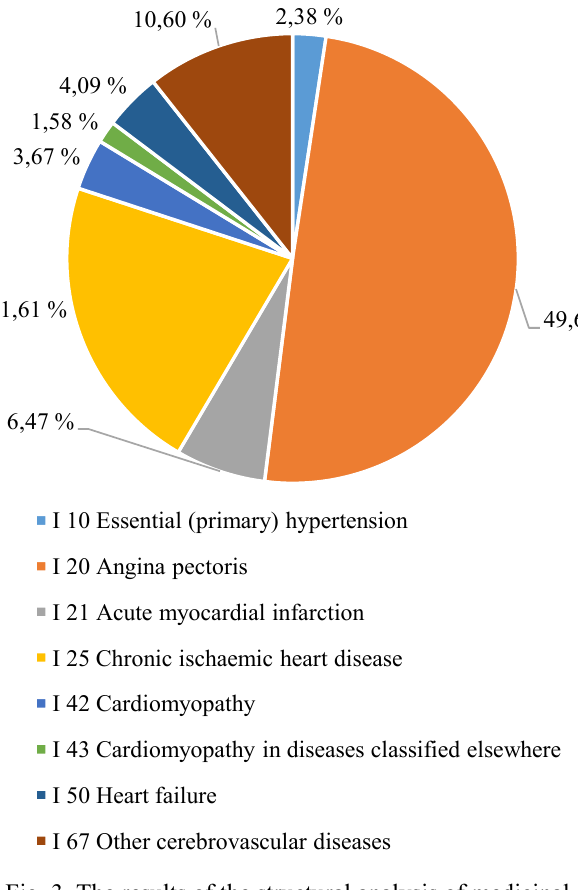
Fig. 3. The results of the structural analysis of medicinal products for patients with cardiovascular pathology at the 2nd level of ICD-10 (version